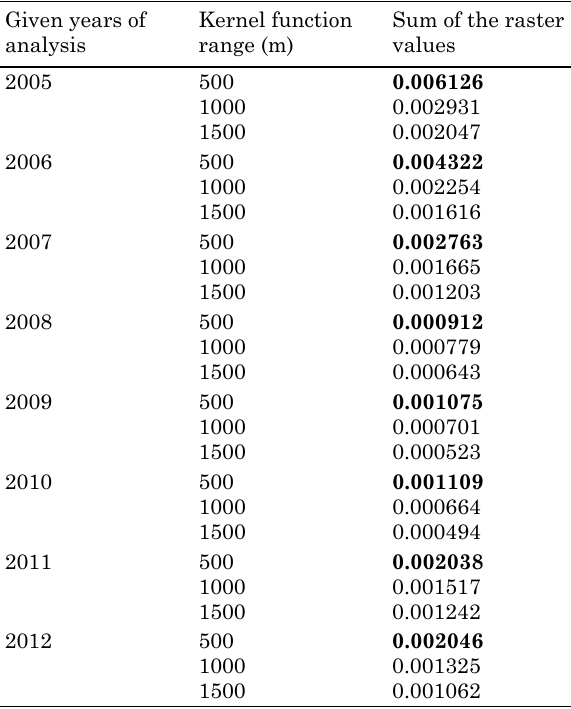
Table 1. Results of analyses regarding the selection of kernel functions in respective years of